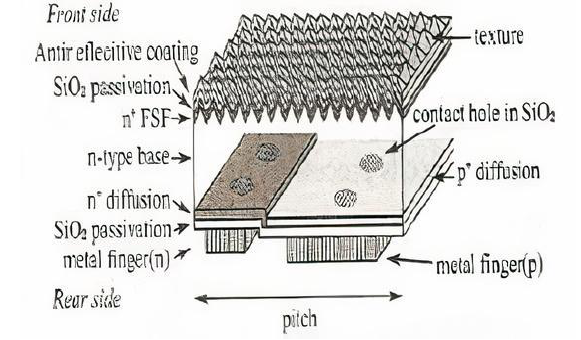
Fig. 4. Fabrication of HIT PV Cell